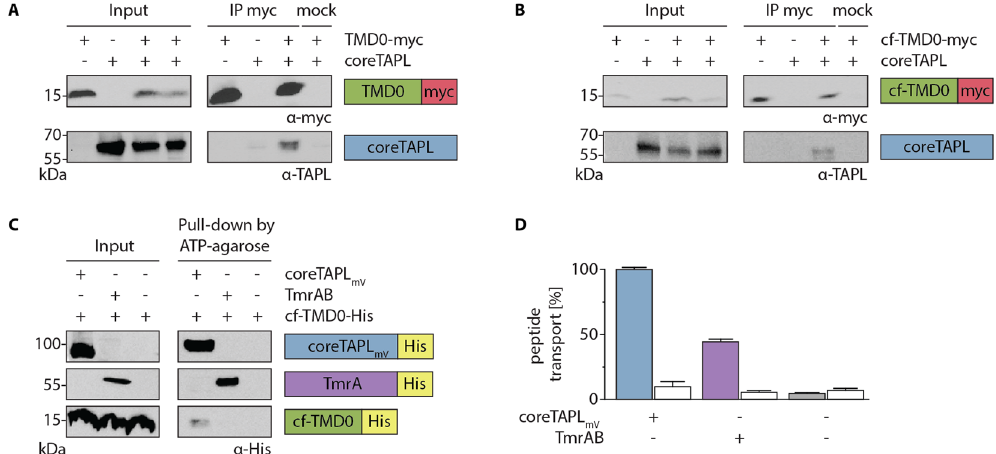
Figure 2. Cf expressed TMD0 is correctly folded. ( A , B ) Interaction of coreTAPL with TMD0. HEK 293 T cells were transiently transfected with coreTAPL and TMD0-myc ( A ) or cf-TMD0-myc ( B ). After solubilization with 1% digitonin (input), co-immunoprecipitation with myc-tag specific antibody (IP myc) or isotope control (mock) was performed and analyzed by immunoblotting. Input represents 1/25 aliquot of the volume used for immunoprecipitation. Original, uncropped immunoblots are shown in supplementary information. ( C ) To probe correct folding of cf expressed TMD0, cf-TMD0-His was reconstituted into proteoliposomes alone or together with coreTAPL mV or TmrAB (input). After solubilization with 2% digitonin, coreTAPL mV or TmrAB were pulled-down with ATP-agarose and analyzed by immunoblotting using a His-tag antibody. Input represents 1/20 aliquot of the volume used for pull-down. Original, uncropped immunoblots are shown in supplementary information. ( D ) To confirm functional reconstitution, proteoliposomes containing only cf- TMD0-His or cf-TMD0-His and coreTAPL mV or TmrAB were incubated in the presence (filled bars) or absence (open bar) of ATP (3 mM) with peptide (3 µ M) for 15 min at 37 °C. Transport assay was performed in triplicates and normalized, error bars indicate